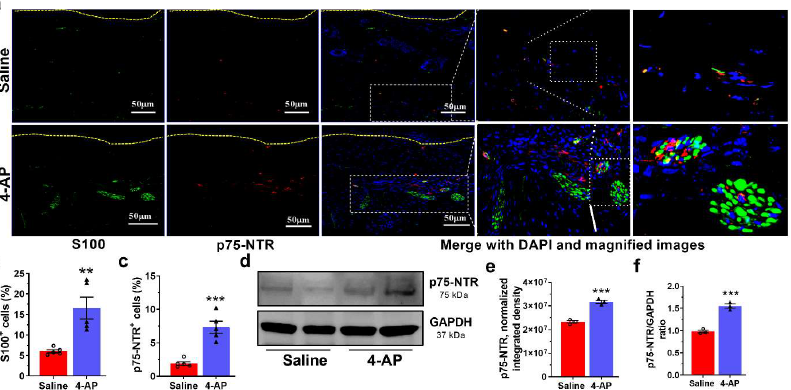
Figure 5. 4-AP increases the number of Schwann cells and the expression of markers of an early SC differentiation state. ( a ) Representative image of co-immunostaining of S100 (green) and p75-NTR (red) in wound sections and dashed line denotes epidermal/dermal border. Scale bars = 50 μm. ( b , c ) Quantification of S100 + and p75-NTR + expressing cells in healed wounds. Data represents 20 images from 5 different mouse wounds and are shown as mean ± SEM, n = 5 animals per group, statistical significance indicated by asterisks (O = saline mouse data points, ∆ = 4-AP treated mouse data points, ** = p between 0.01 and 0.001, and *** = p between 0.001 and 0.0002 vs. saline). ( d ) Representative image of Western blot of p75-NTR and GAPDH. ( e , f ) Normalized integrated densities and the ratio of p75-NTR protein expression represented as mean ± SEM, n = 5 animals per group, statistical significance indicated by asterisks (O = saline mouse data points, ∆ = 4-AP treated mouse data points, *** = p between 0.001 and 0.0002 vs. saline). Biomedicines 2022 , 10 , x FOR PEER REVIEW